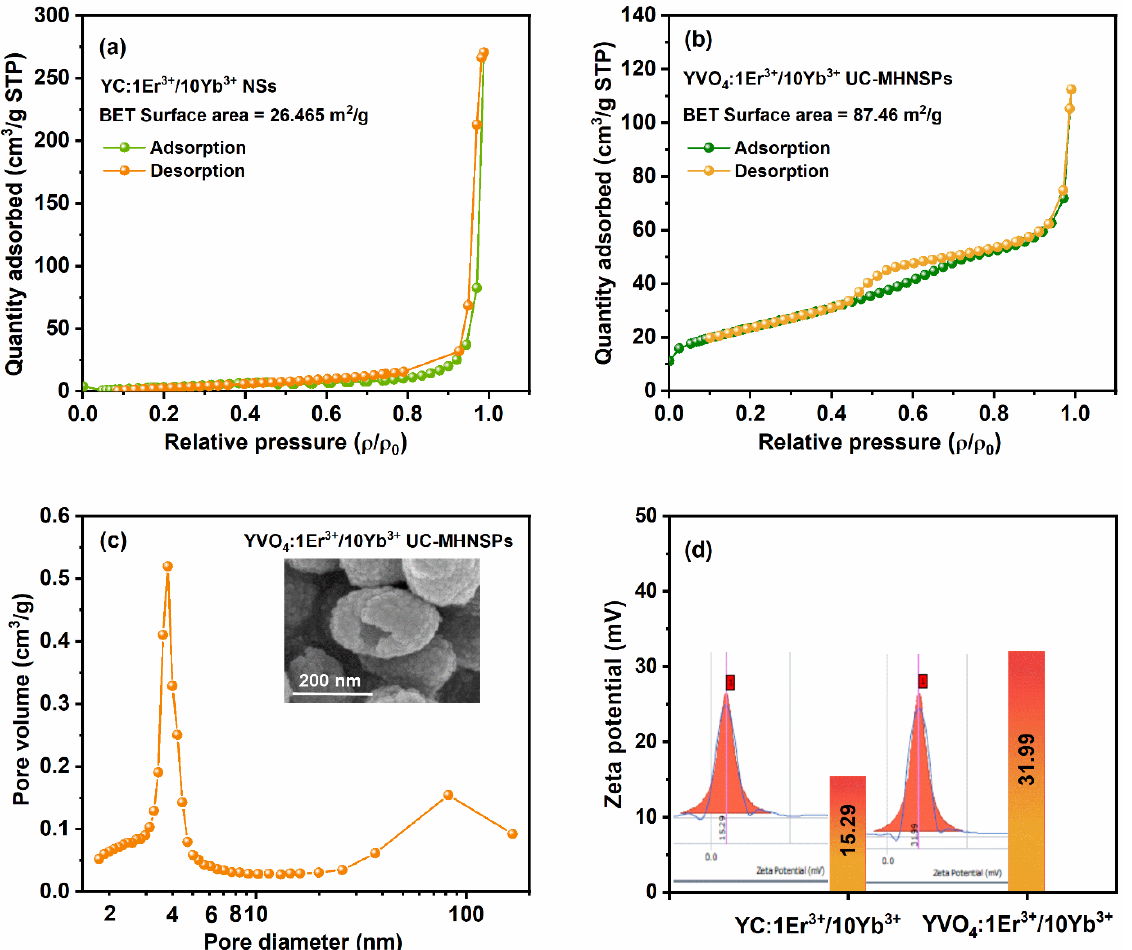
Figure 4. ( a , b ) Nitrogen adsorption desorption isotherms of YC:Er 3+ /Yb 3+ NSs and YVO 4 :Er 3+ /Yb 3+ UC-MHNSPs, ( c ) pore size distribution plot of YVO 4 :Er 3+ /Yb 3+ UC-MHNSPs, and ( d ) particle zeta potential value and the related distribution graphs of NSs and UC-MHNSPs.